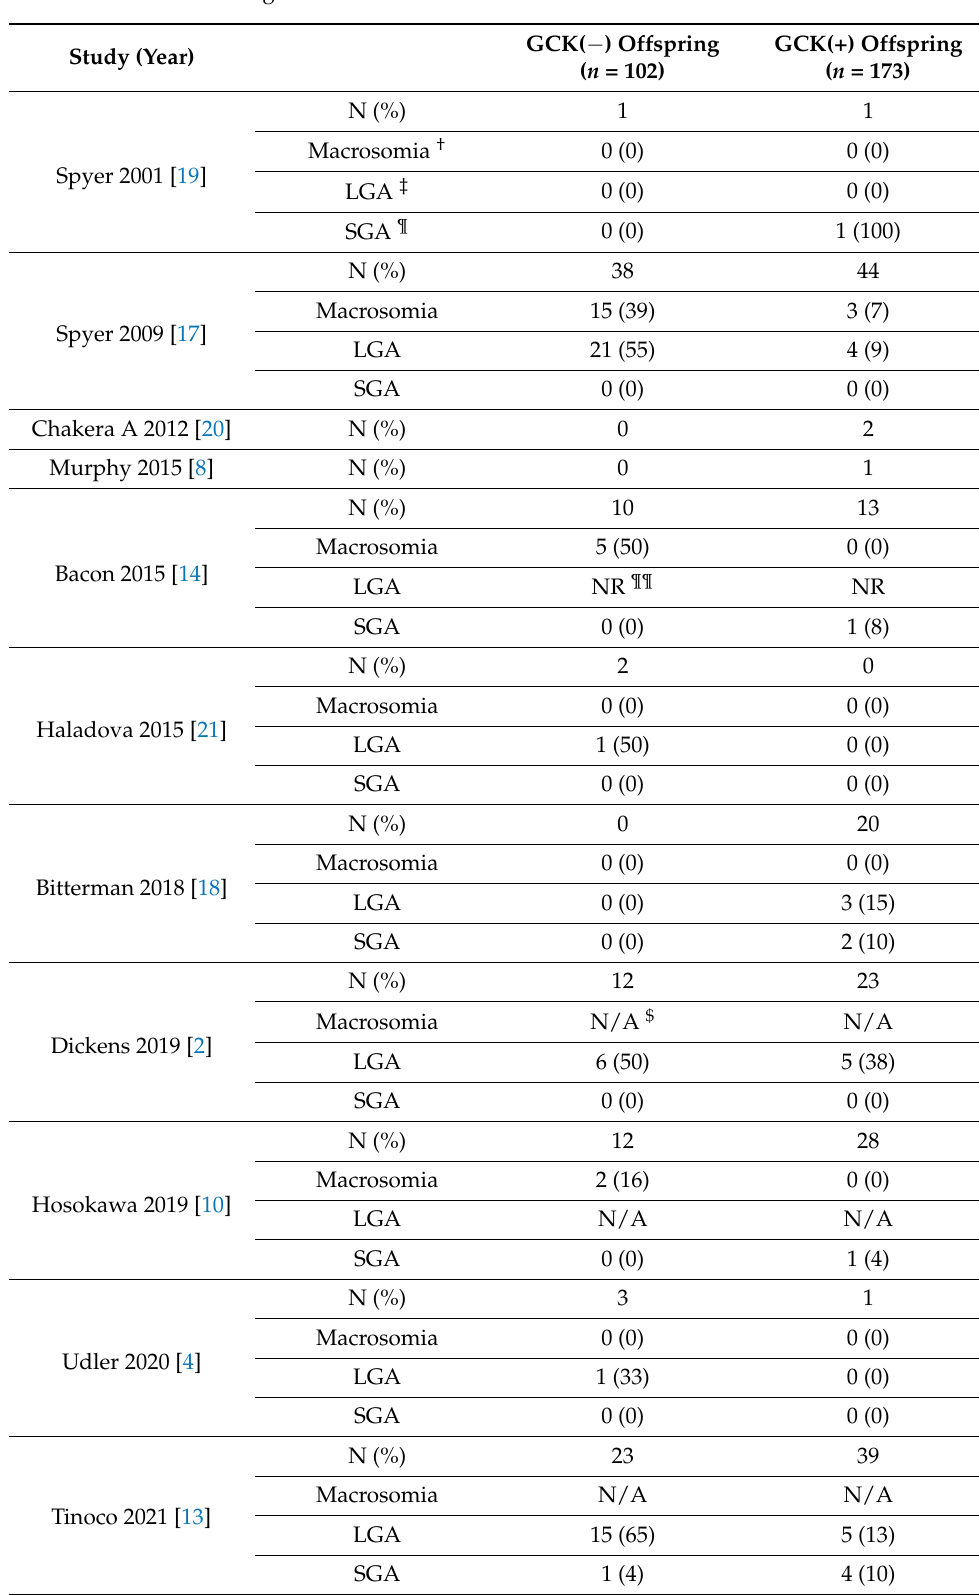
Table 4. Data on